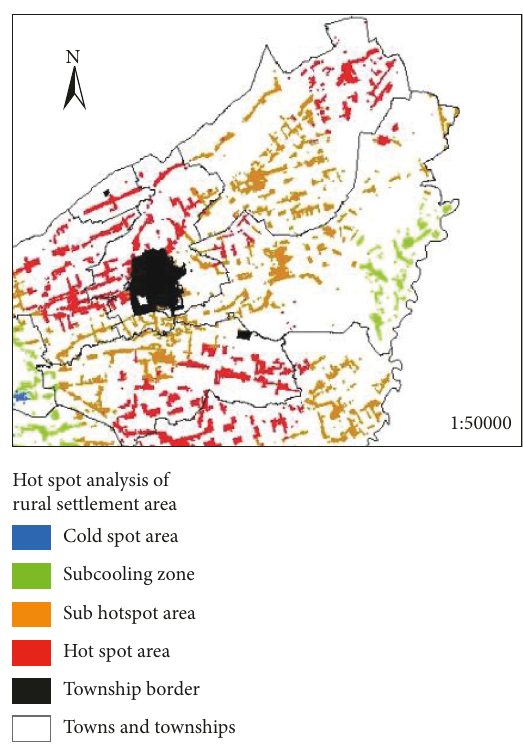
Figure 5: “Hot spot” map of plant size difference.